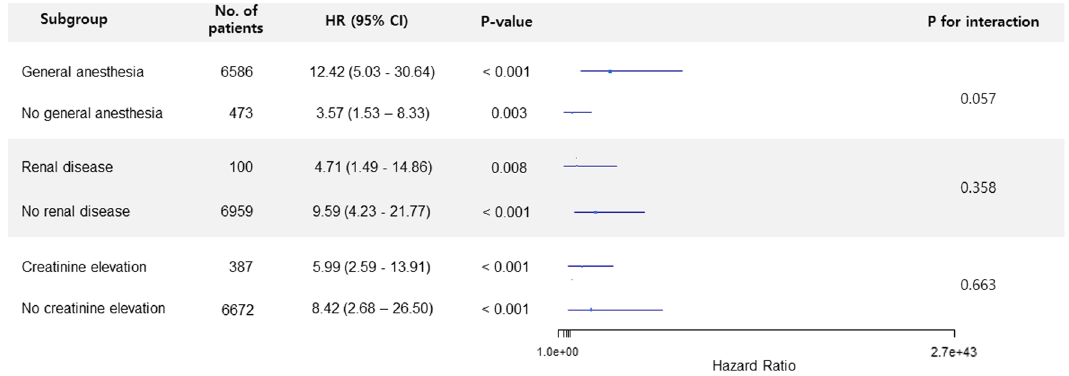
Figure 4. Forest plot of subgroup analysis according to general anesthesia and previous renal